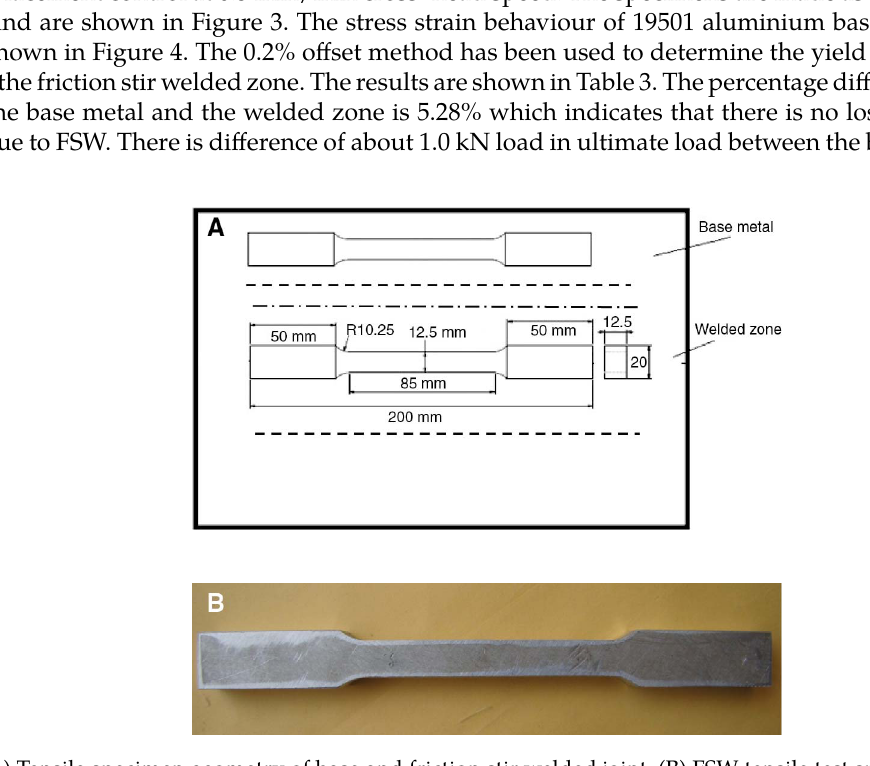
Figure 3: (A) Tensile specimen geometry of base and friction stir welded joint. (B) FSW tensile test specimen.